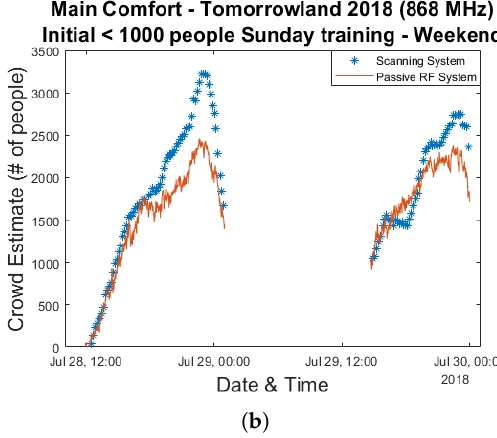
Figure 8. Crowd estimation graphs and their corresponding error graphs for a model trained using the max count from a single day and evaluated based on data collected during the other day. Plots ( a , c ) show the results of training based on the max count of Sunday 29 July 2018 and evaluation based on data from Saturday 28 July 2018. Plots ( b , d ) show the results of training based on the max count of Saturday 28 July 2018 and evaluation based on data from Sunday 29 July 2018.